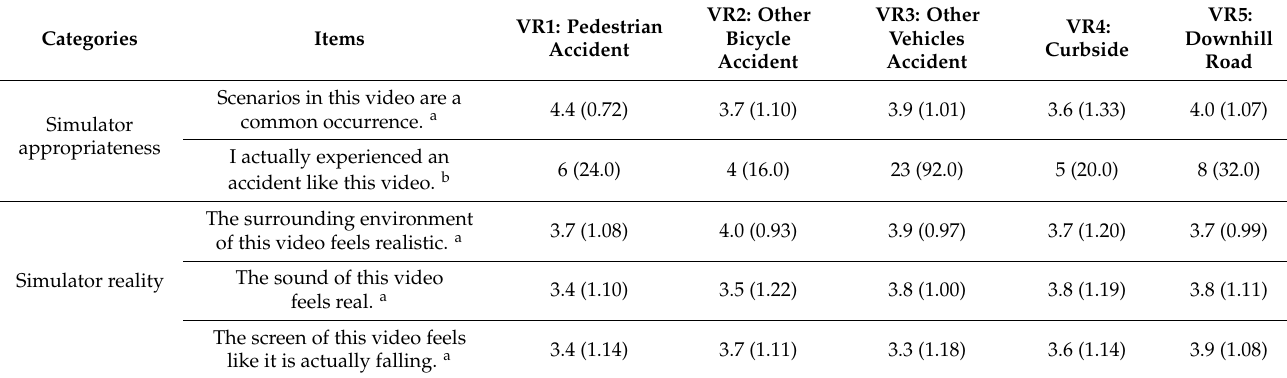
Table A1. Evaluation of a 360 ◦ virtual reality